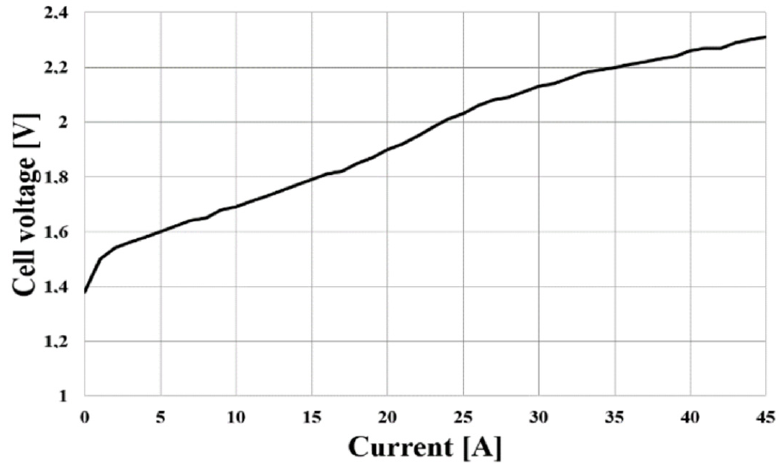
Figure 2. Static curve of the single-cell PEM electrolyzer used.